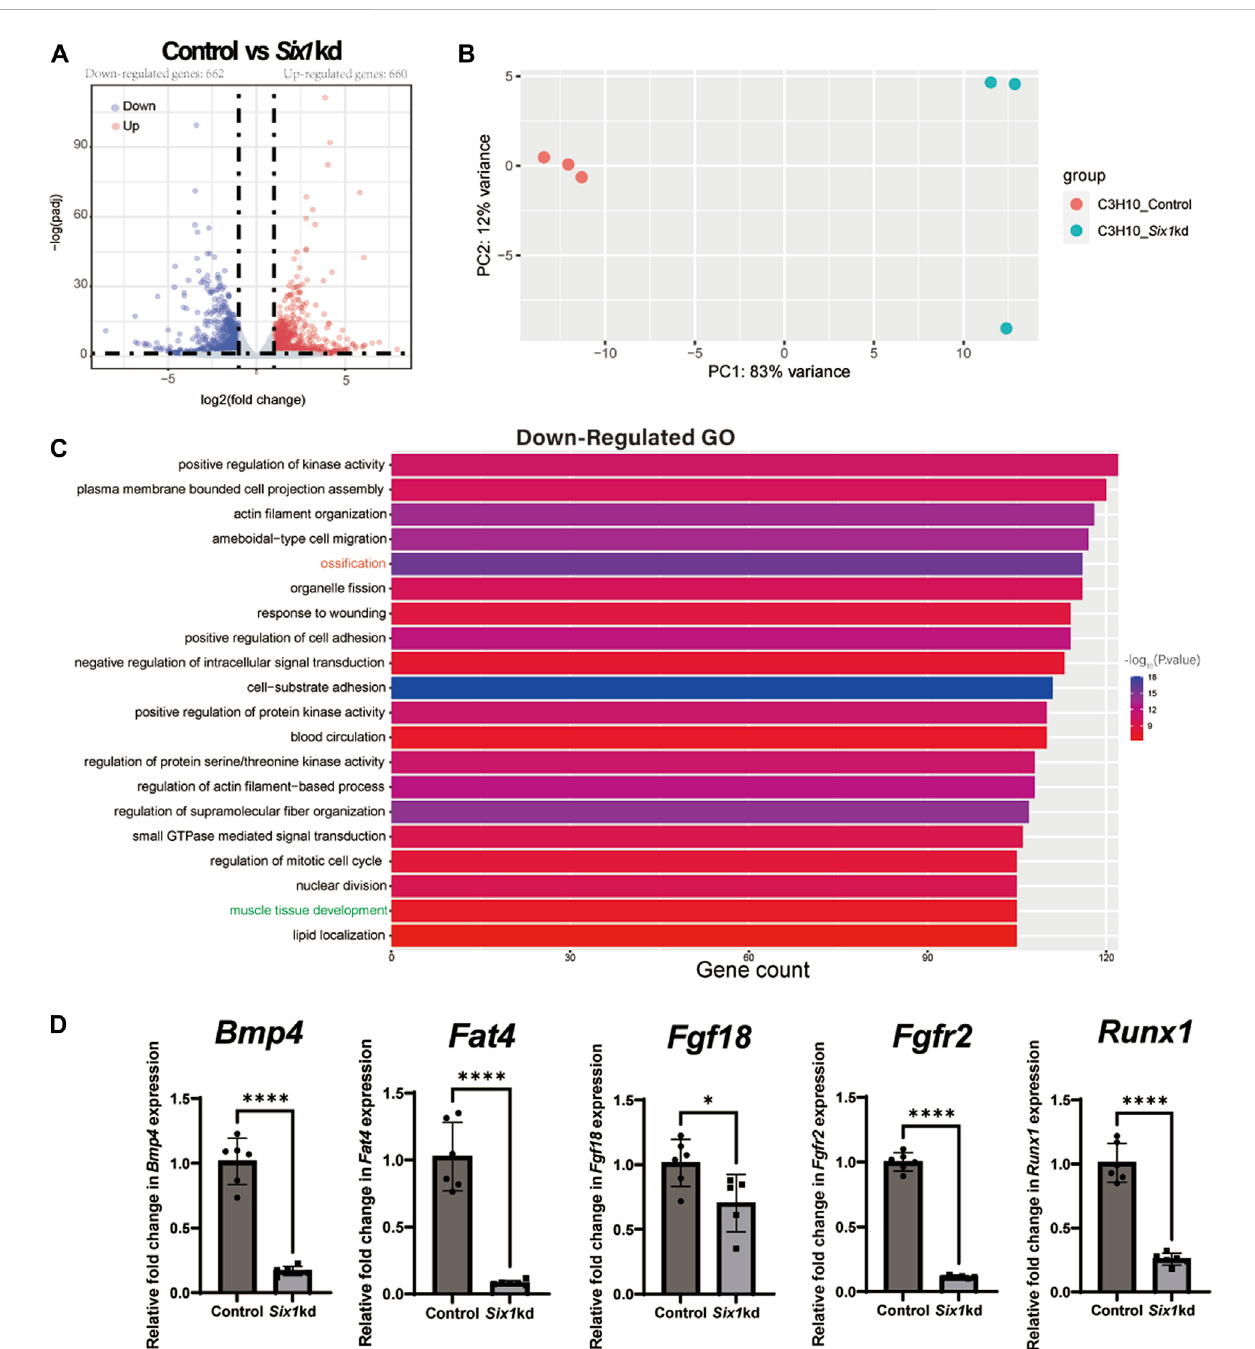
FIGURE 5 RNA-seq of C3H10 T1/2 cells transfected with negative control (Control) or Six1- shRNAs ( Six1 kd) lentivirus (n = 3). (A) Volcano plots for all the genes of thecontroland Six1 kdgroups.Dotsonbothsidesindicateupanddownregulateddifferentiallyexpressedgenes(DEGs;p-adj < 0.05). (B) PCAplotshowingthe correlation between RNA-seq replicates. (C) The terms associated with biological processes (p-adj < 0.05) involving the downregulated genes in the Six1 kd group. (D) RT-qPCR analysis of Bmp4 , Fat4 , Fgf18 , Fgfr2 , and Runx1 in control and Six1 kd